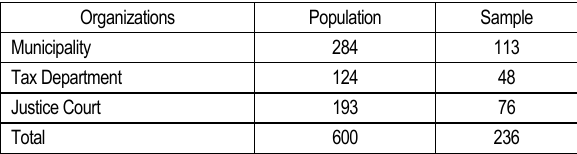
Table 1. Distribution of samples in organizations